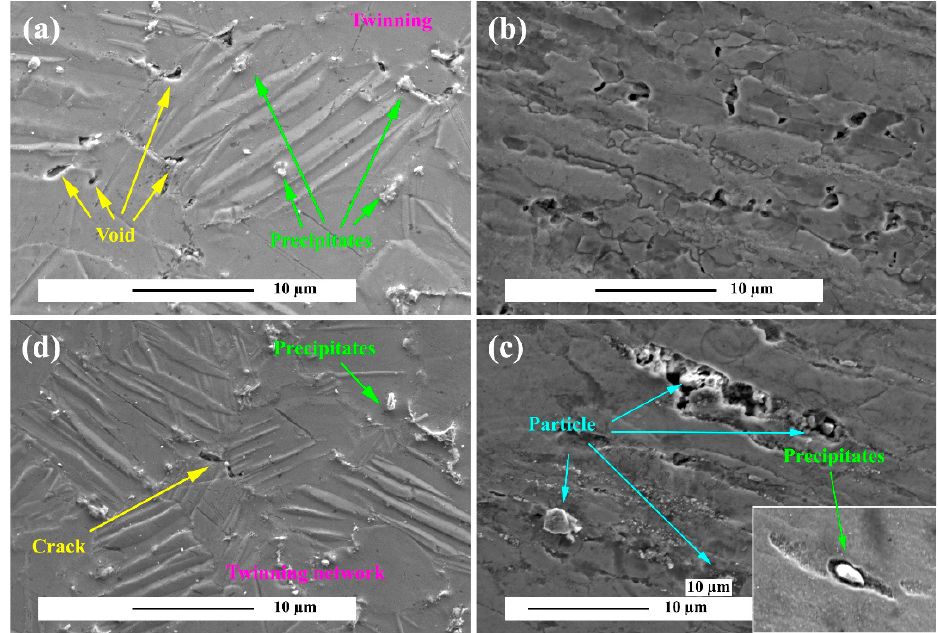
Figure 14. Formation of cavities and cracks at the twin and grain boundaries after creep at 150 °C under 39 MPa stress in the sample: ( a , b ) unreinforced alloy, ( c , d ) ZK60/SiCp composite.